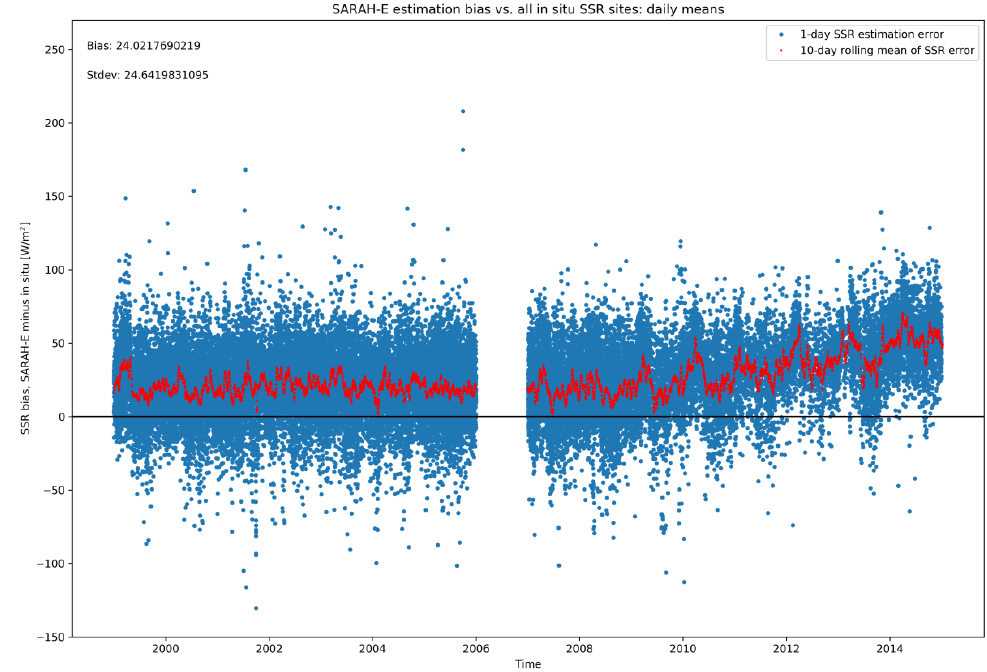
Figure 2. SARAH-E SSR estimation bias versus all in situ measurement sites. Blue markers are the daily mean SSR estimation errors (marker per site per day), while the red markers are the 10-day rolling mean of estimation errors.